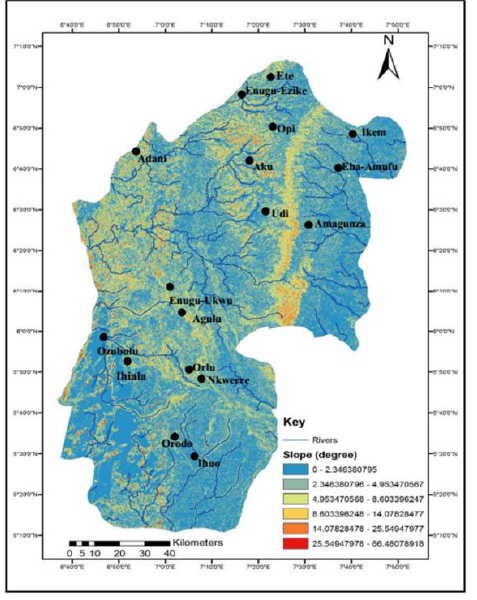
Figure 4: Slope Map of the Study Area.